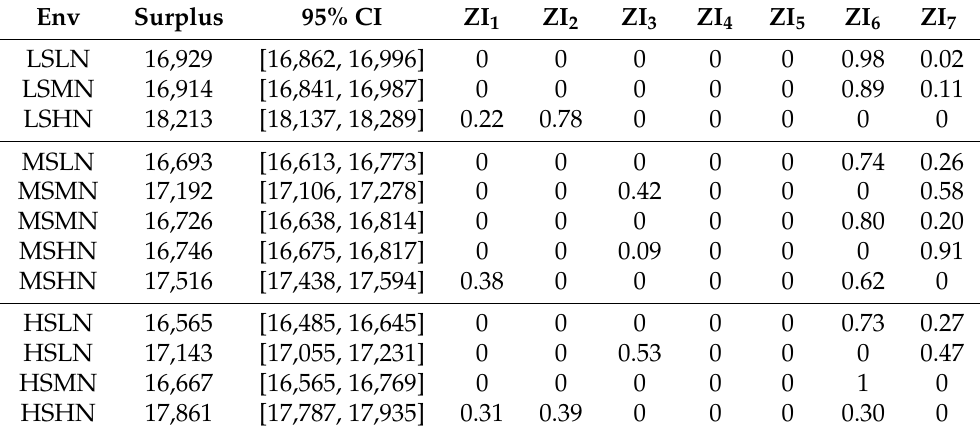
Table A9. Equilibria for games where agents are restricted to ZI strategies, N = 28, calculated from the four-player DPR approximation. Each row of the table describes one equilibrium found with its corresponding surplus and the equilibrium mixture probabilities of strategies included. Env